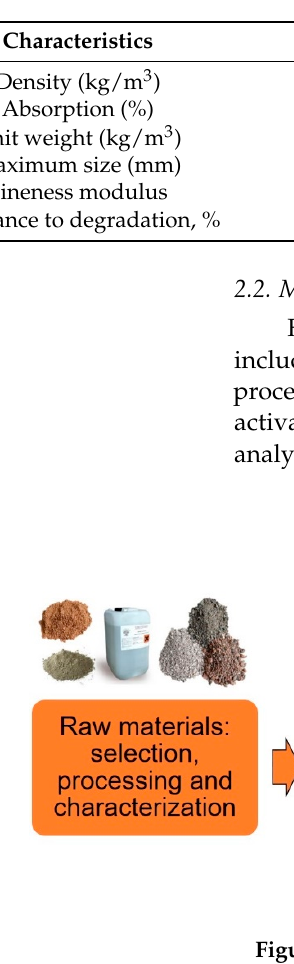
Table 2. Characteristics of the aggregates (natural and recycled) used in the production of the blocks.